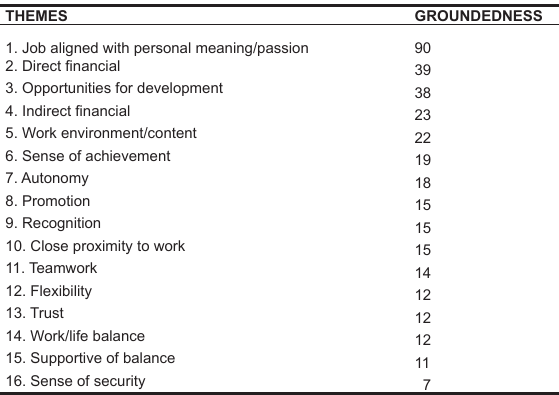
TABLE 2 Themes as deduced from the responses of research participant